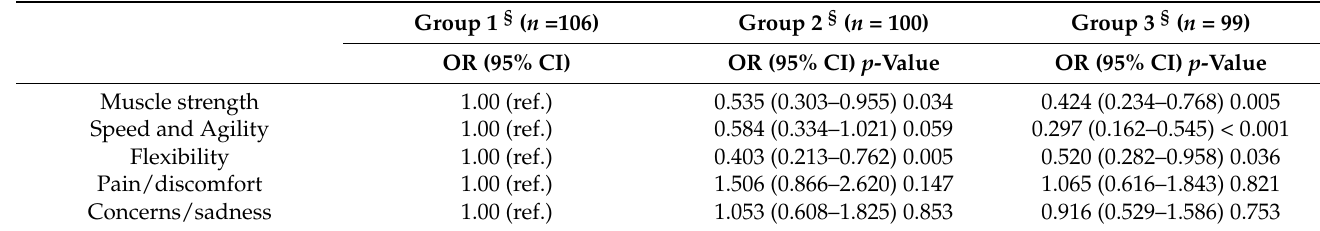
Table 5. Association between the fitness status of children and their life